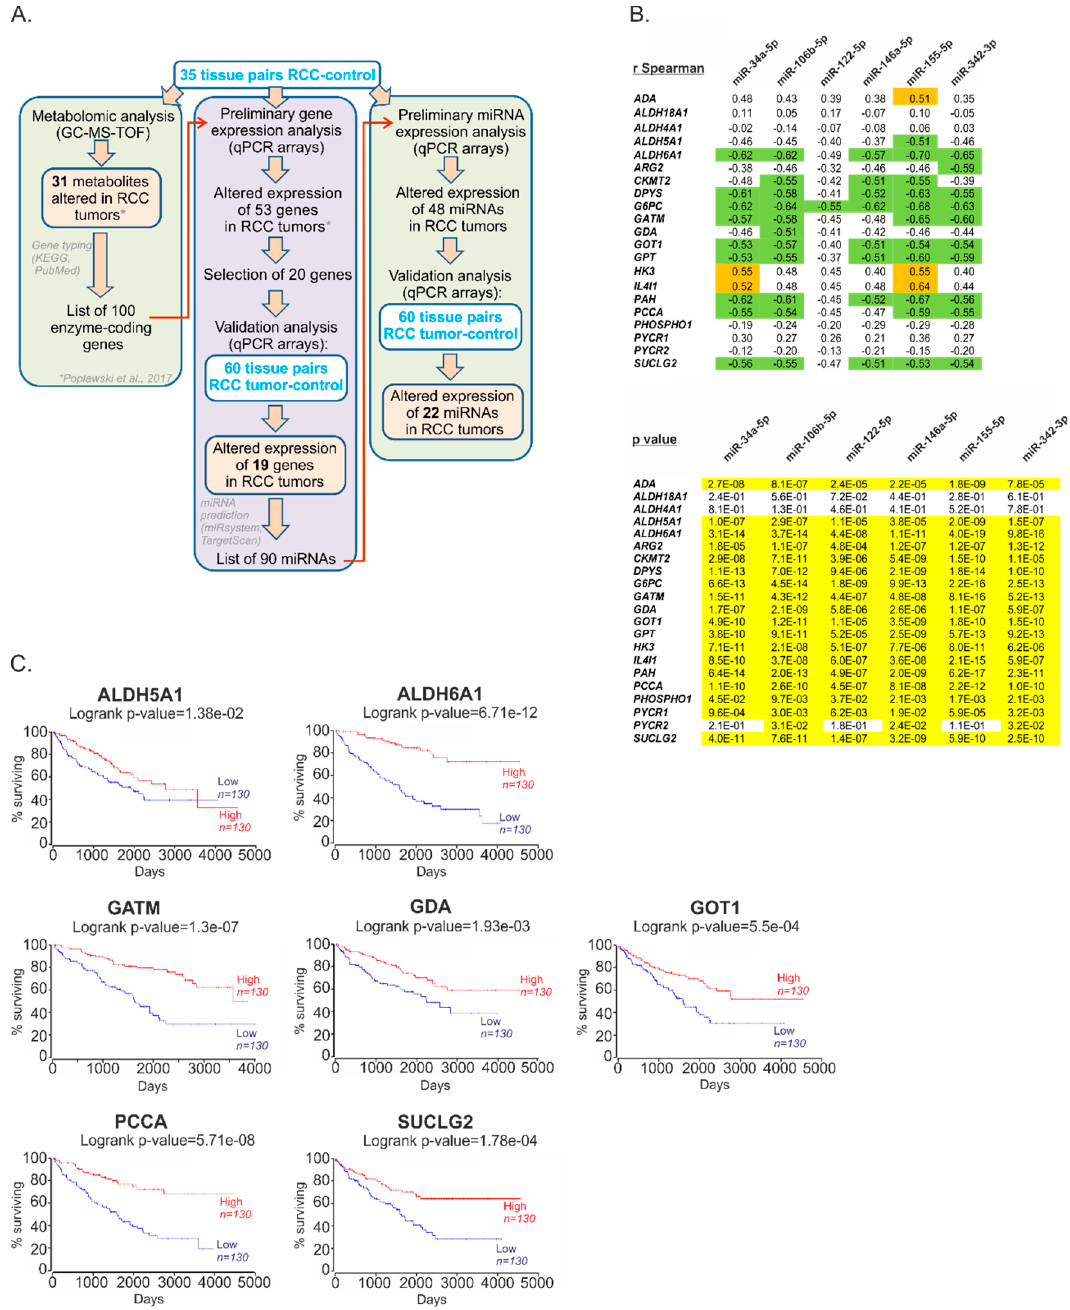
Figure 1. The expressions of microRNAs in relation to their predicted metabolically relevant gene targets. ( A ) The scheme of analysis of miRNAs predicted to regulated RCC metabolome. ( B ) Correlations between the expressions of metabolic genes and their predicted regulatory microRNAs, selected for functional analysis. Upper panel shows correlation coefficients. Green: r Spearman < − 0.5; orange: r Spearman > 0.5. Lower panel: p values. Yellow: p < 0.05. Full data of correlation analysis are given in Table S3. N = 60 of RCC tumor samples and n = 60 of control tissue samples. ( C ) Altered expression of metabolic genes correlates with poor survival of RCC patients. Kaplan–Meier plots were generated using OncoLnc tool and KIRC (Kidney Renal Clear Cell Carcinoma) cohort of TCGA (The Cancer Genome Atlas) data. Patients were classified into Low and High expression groups basing on median mRNA expression (the expression profiles in two groups of patients are given in Figure S1). N = 260.